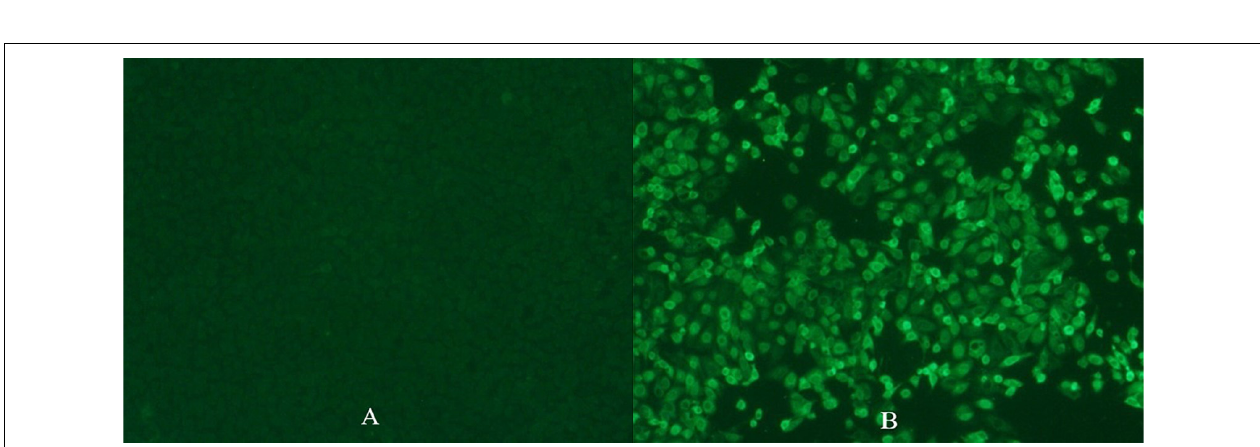
FIGURE 5 | Views of MARC-145 cells at 3 days postinoculation with control impinger fluid (A) and with the collected PRRSV impinger fluid (B) . Magnification, × 160.